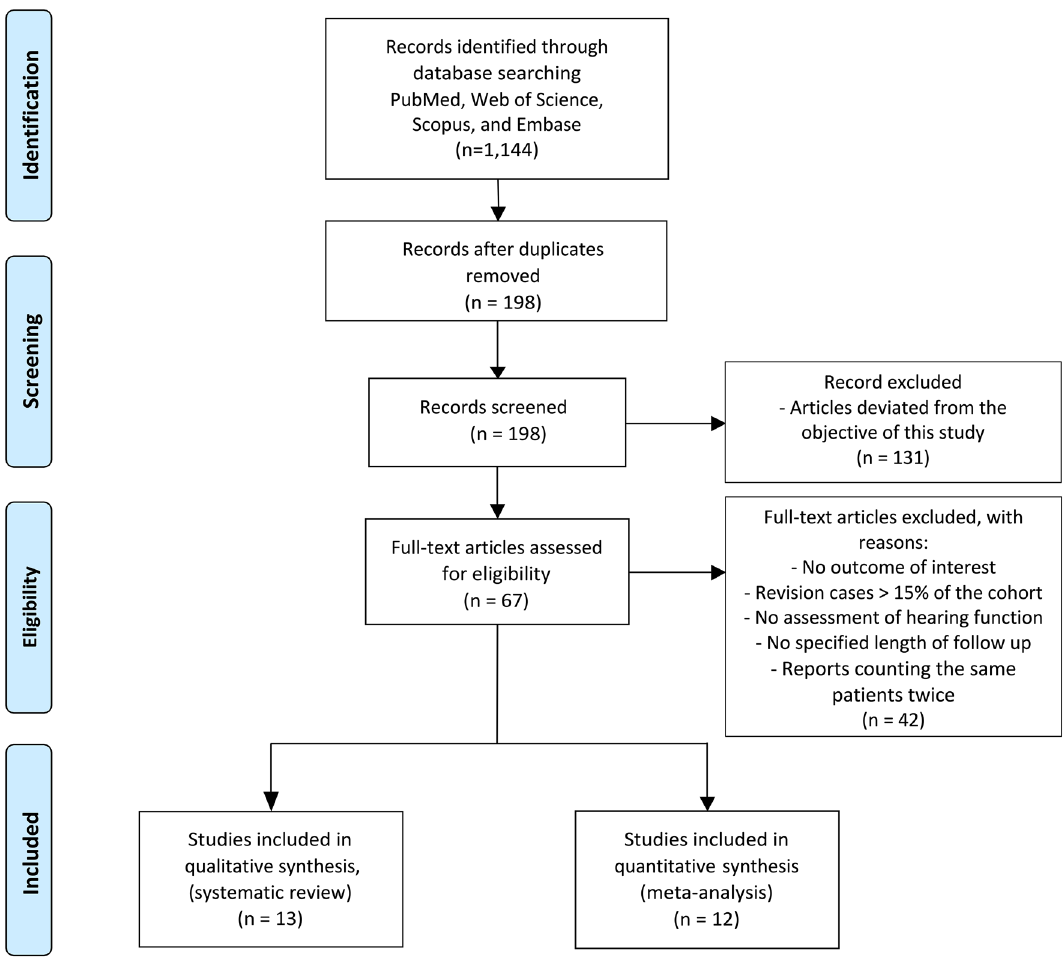
Figure 1. PRISMA flow diagram. A total of 1144 articles were retrieved from the search process. After removing duplicates, 198 studies were screened at the abstract level. After removing articles (n = 131) that deviated from the objective of this study, 67 articles were reviewed at full text. 42 articles did not satisfy the inclusion criteria and were excluded from subsequent screening. Among the articles left, 13 met the inclusion criteria for the systematic review, and 12 different studies met the inclusion criteria for the